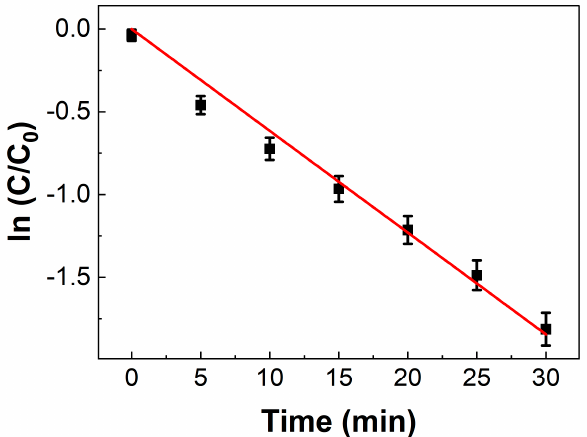
Figure 4. Pseudo-first-order reaction rate plot for electron-transfer reaction between hexacyanofer- rate(III) and thiosulfate ions. The initial concentration of hexacyanoferrate(III) is 10 − 3 M, and the initial concentration of thiosulfate is 0.2 M. The Pt concentration is 65.8 μ M. The reaction takes place at 25 °C.